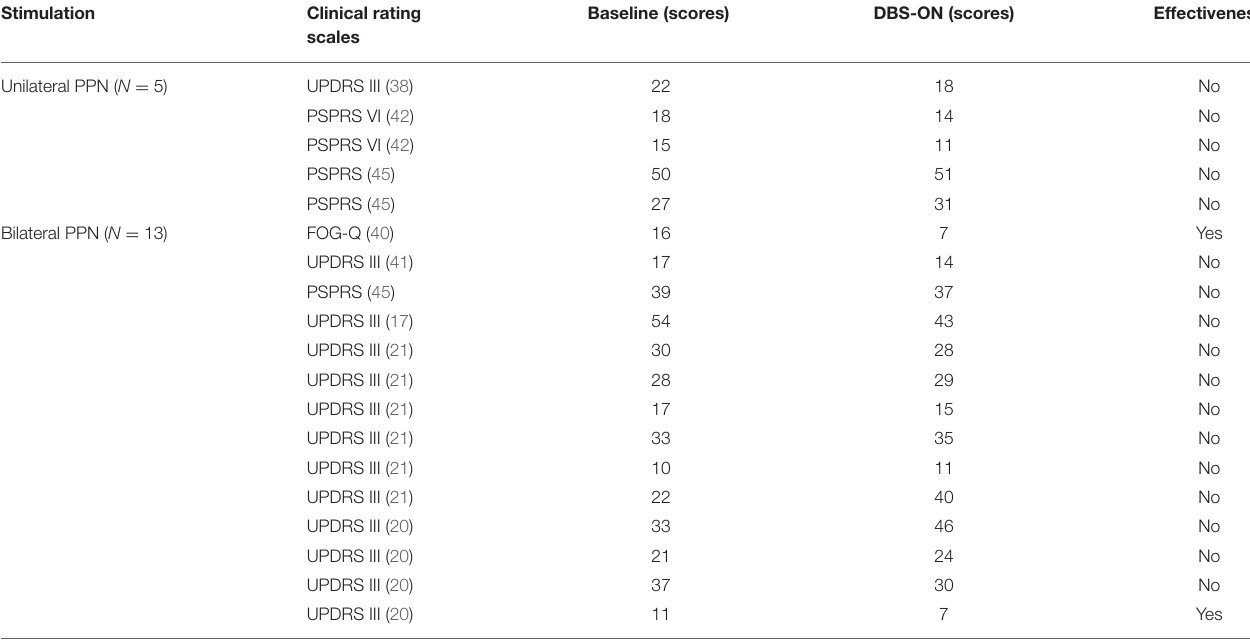
Bilateral PPN ( N =